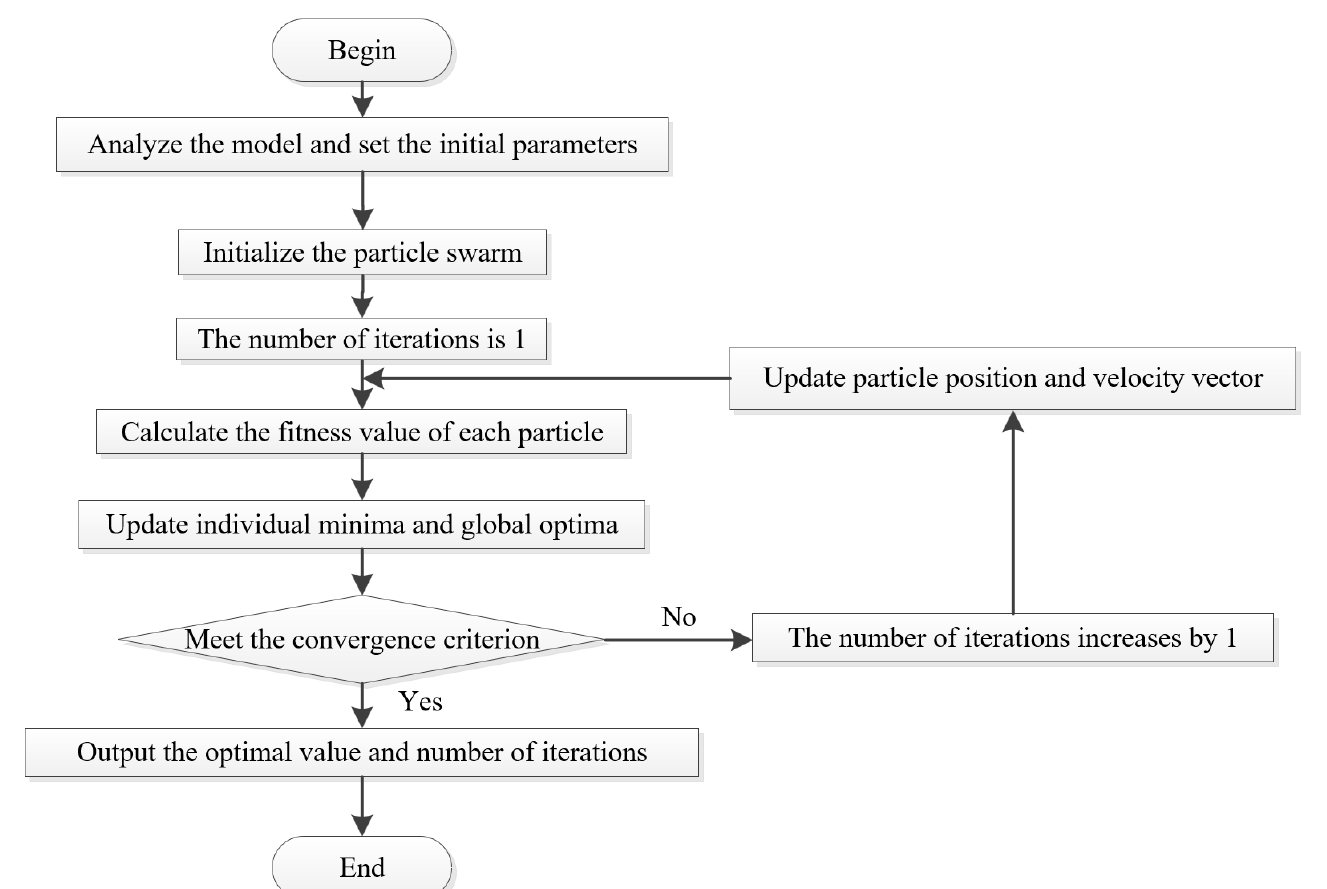
Figure 13. Flow chart of the particle swarm optimization algorithm.